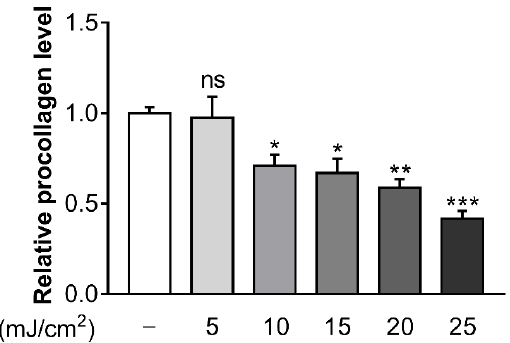
Figure 1. Ultraviolet B (UVB) inhibits procollagen synthesis in Hs68 cells. The cells were irradiated for 24 h with various doses of UVB (5, 10, 15, 20 and 25 µ M). Procollagen concentration was determined by enzyme linked immunosorbent assay (ELISA) assay. Data are presented as mean ± standard error of the mean (SEM) of three independent experiments. Statistically significant differences are marked as * p < 0.05, ** p < 0.01, *** p < 0.001; ns, not